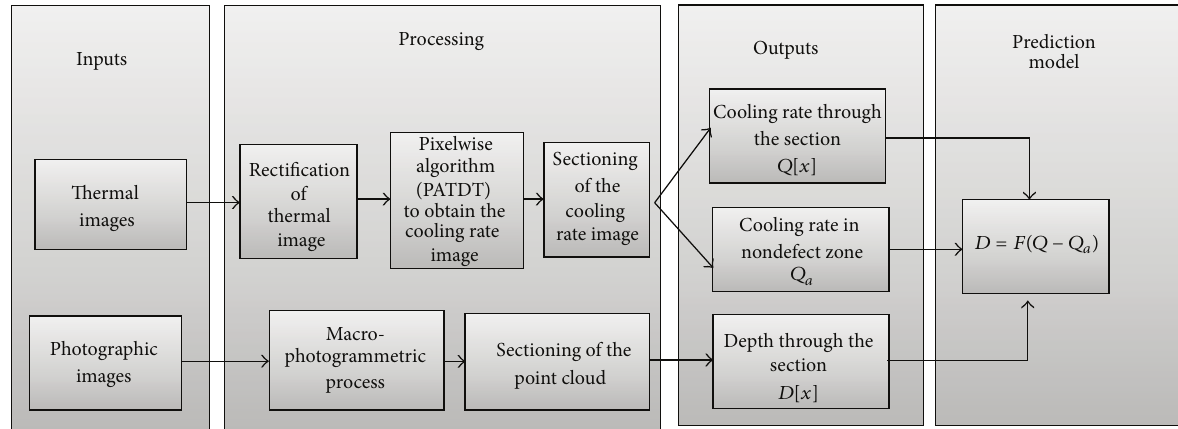
Figure 2: Methodology followed to obtain the prediction model. Inputs are the thermal and photographic images. Processing has two parts: the thermal procedure (firstly, the rectification of the image is implemented, after a PATDT algorithm is applied in order to obtain the cooling rateforeachpixeloftheimage;subsequently,sectioningoftheimagethroughdifferentlinesisimplementedinordertogetdiscretecoolingrate functions) and the macrophotogrammetric procedure [10]. Finally, the processing of the inputs allows obtaining the cooling rates and depths through a concrete different section of the crack; with these outputs, a mathematical approach is applied in order to obtain the prediction